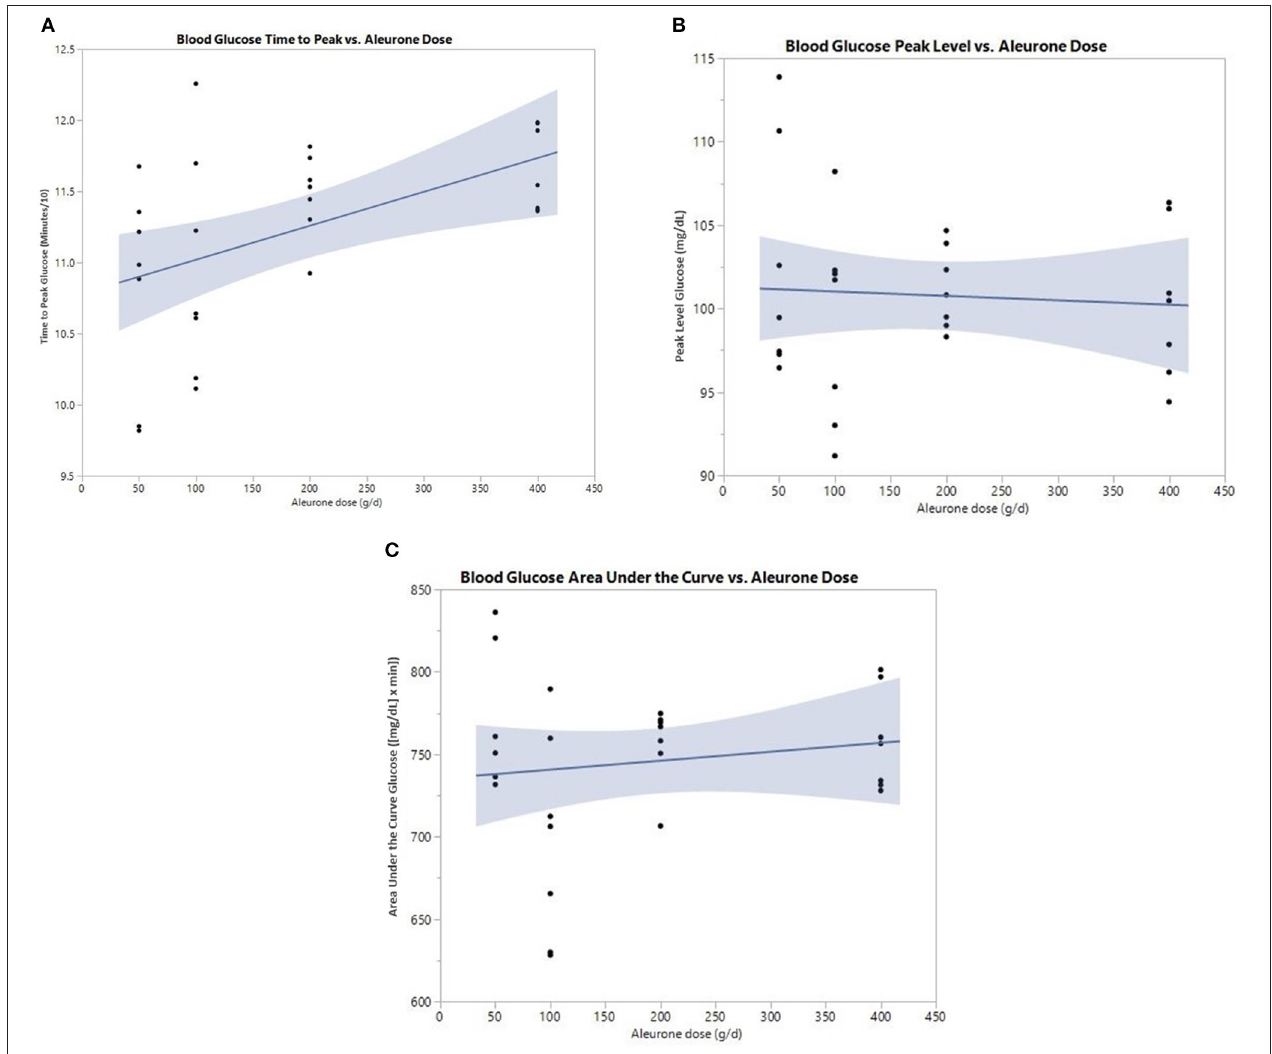
FIGURE 1 | (A) Postprandial time to peak (min/10) of blood glucose after supplementing horses with either 0, 50, 100, 200, or 400g of aleurone. (B) Postprandial peak level of blood glucose (mg/dl) after supplementing horses with either 0, 50, 100, 200, or 400g of aleurone. (C) Postprandial blood glucose area under the curve (AUC) [(mg/dl) × min] after supplementing horses with either 0, 50, 100, 200, or 400g of